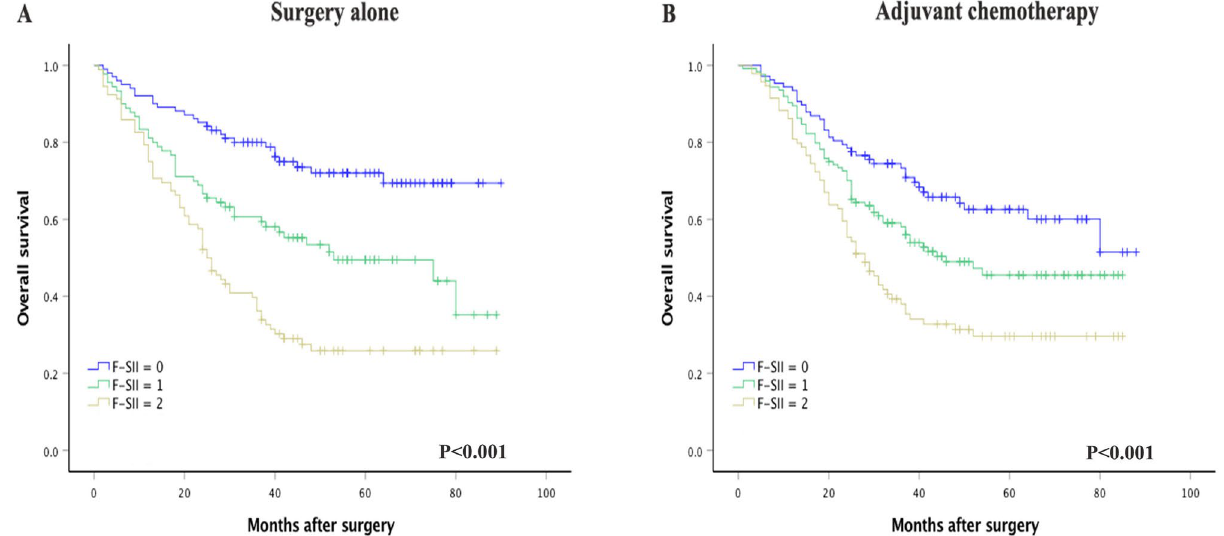
Figure 3. ( A ) Association of the F-SII score with the OS in the surgery alone group. ( B ) Association of the F-SII score with the OS in the adjuvant chemotherapy